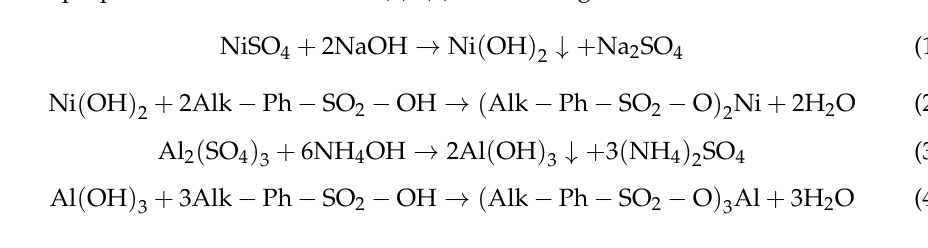
Figure 5. The proposed s tructural formula of Al ABSA3.2. Upgrading performance of the obtained catalysts.